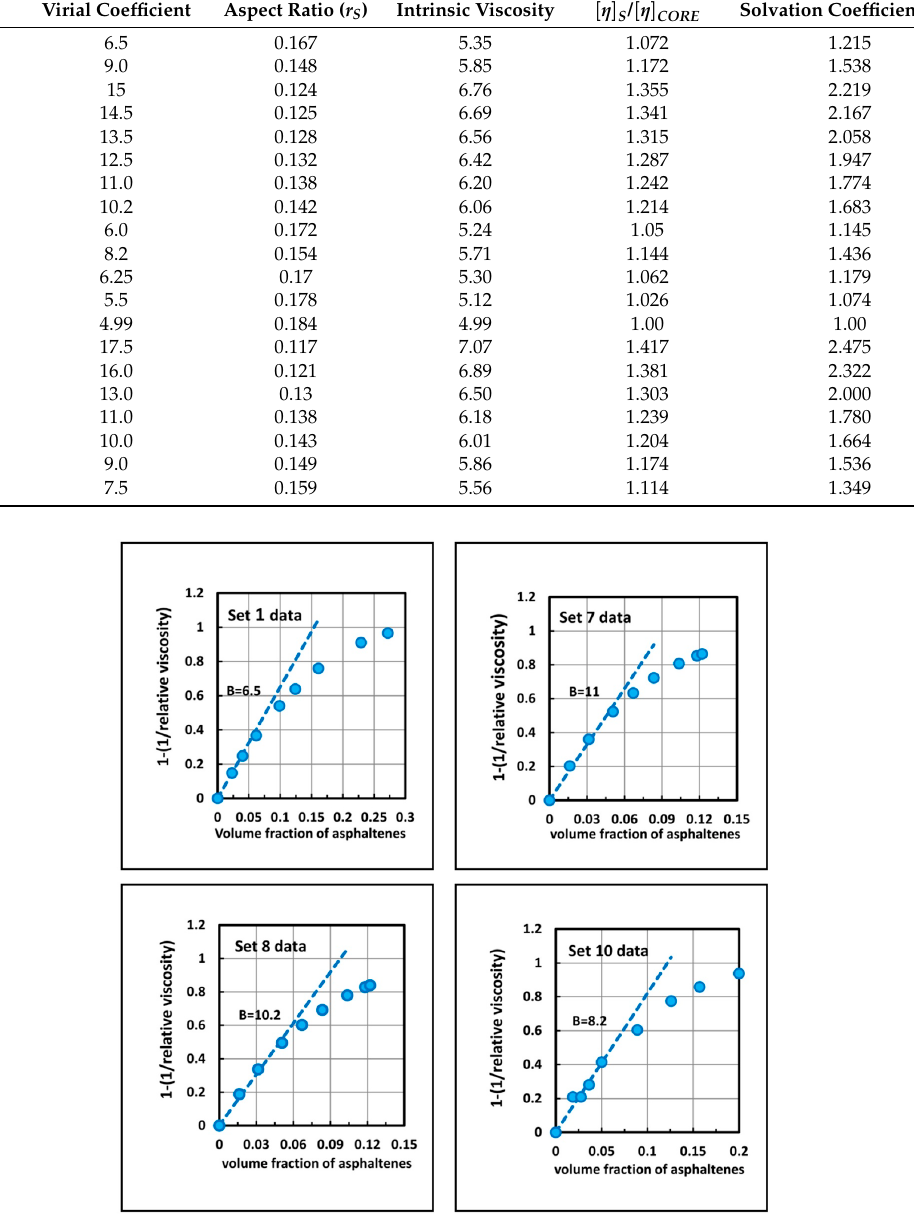
Figure 11. Variations of